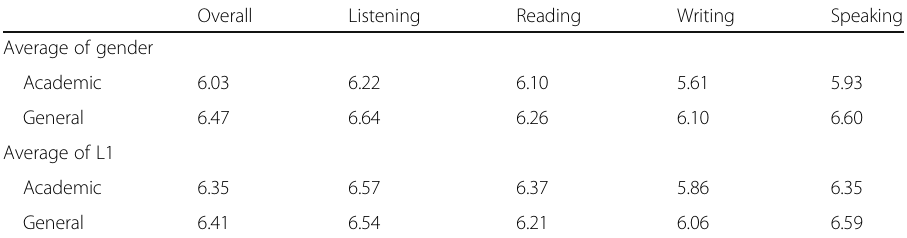
Table 2 Overview of global candidature performance in IELTS in 2017, measured in band scores Overall Listening Reading Writing